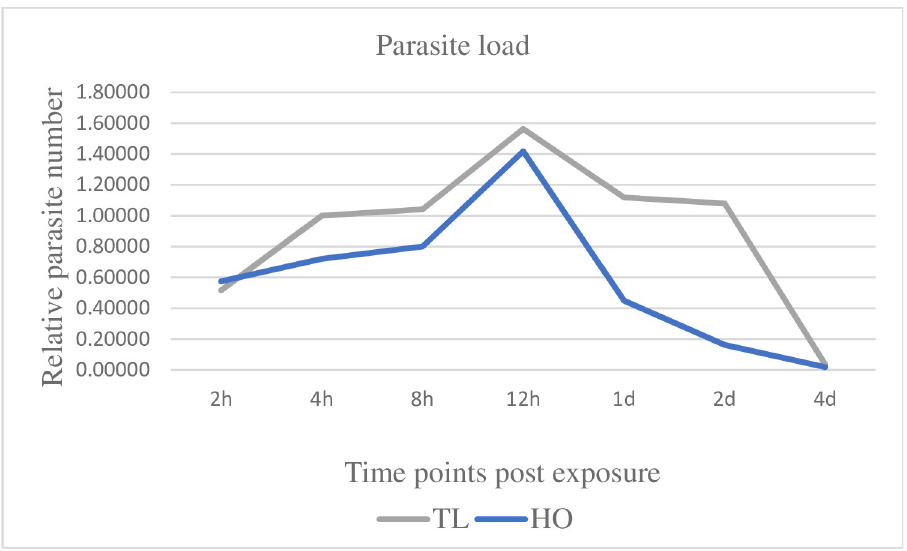
Fig 1. Pathogen load in caudal fin tissues of susceptible Trout Lodge (TL) and resistant Hofer (HO) rainbow trout post exposure to Myxobolus cerebralis . Two days post-exposure (2dpe), the HO strain exhibited a markedly declined parasite count compared to the TL strain. The vast majority of M . cerebralis have migrated from the fins at 4 dpe, and are not quantifiable in skin tissue thereafter.